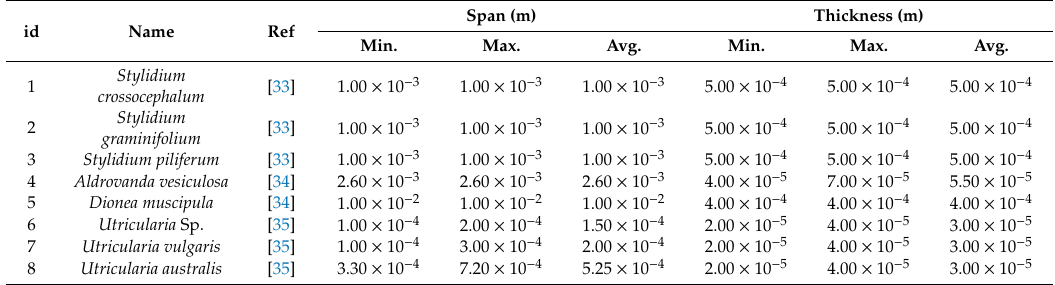
Table A6. Dimensions of the compliant plant thin shells included in the study.